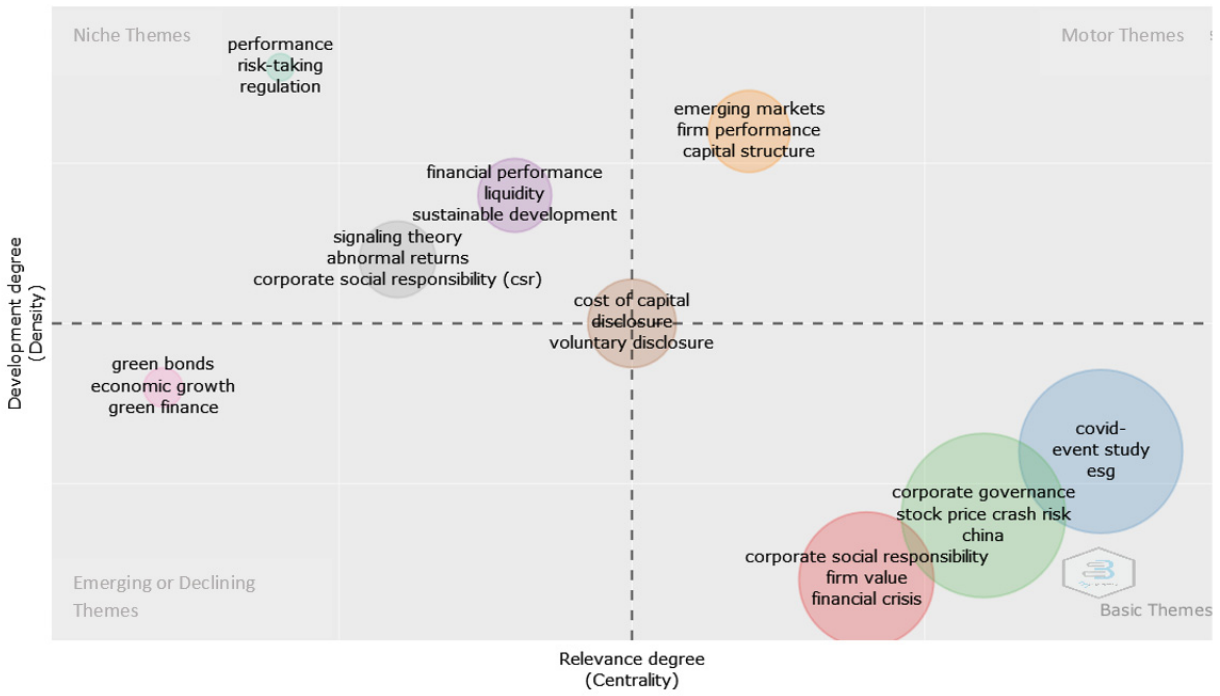
Figure 8. Thematic map based on authors’ keywords. Source: Scopus/Biblioshiny.